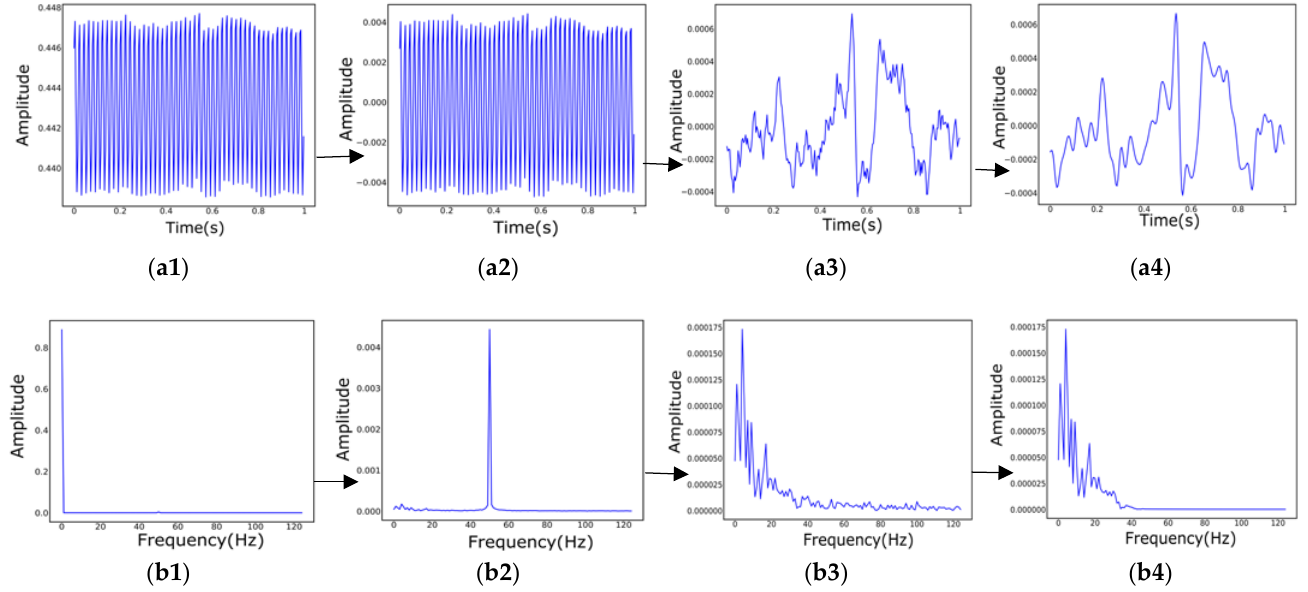
Figure 2. The filtering time and frequency diagram of the preprocessing process (the above shows the filtering process of the Fpz electrode EEG of sample data (subject ID: 02010003), and other samples that are similar). ( a1 – a4 ) Time domain filtering process; ( a1 ) Original time domain diagram; ( a2 ) After 1 Hz high-pass filtering; ( a3 ) After [48, 52] trap filtering; ( a4 ) After [0.5, 35] bandpass filtering; ( b1 – b4 ) The four graphs are, respectively, the frequency domain waveforms of the time domain graphs ( a1 – a4 ).